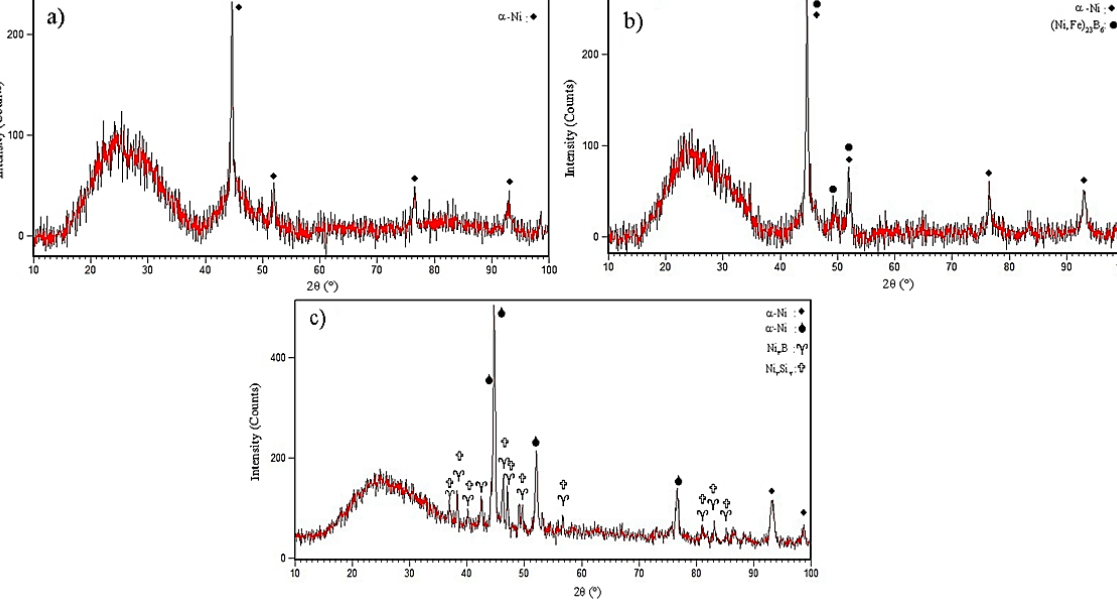
Figure 4. XRD phase analysis of BNi-3 interlayer after annealing under the following conditions: ( a ) 490 °C/10 min, ( b ) 530 °C/10 min, and ( c ) 590 °C/10 min.